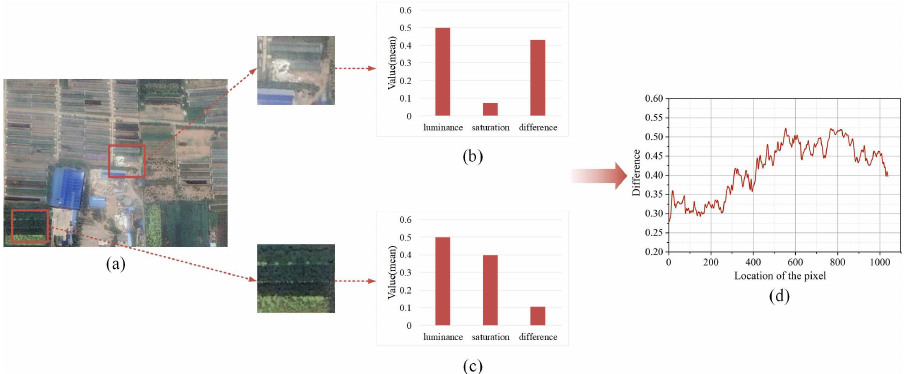
Figure 3. The color attenuation of a hazy remote sensing image. ( a ) A hazy remote sensing image; ( b , c ) the partially enlarged images and the corresponding bar charts; ( d ) the difference between brightness and saturation.